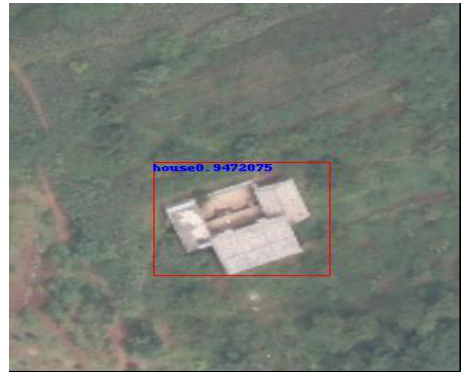
Figure 5. Example of a test result.